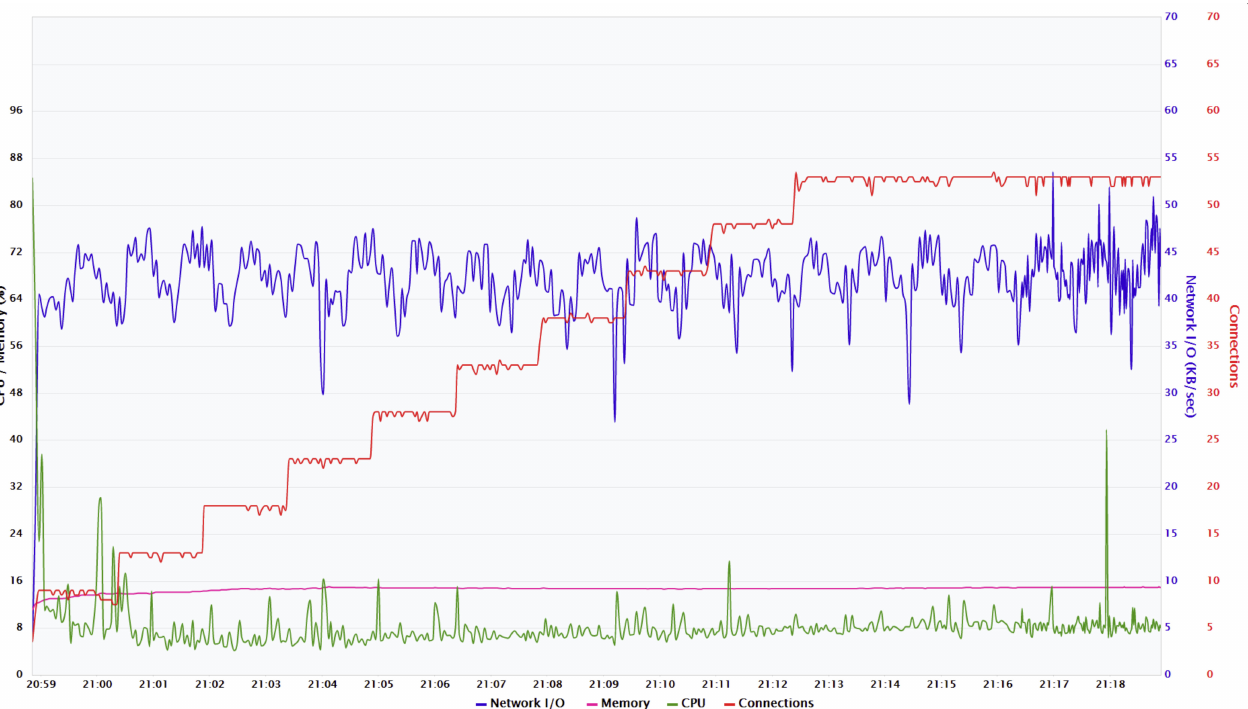
Figure 4. Engine Health Report SPIDEP-SOA-K8s-T1. The colored lines represent various parameters as follows: the blue line is the bandwidth traffic; the purple line is the memory load generated by the users; the green line is the CPU load generated by the users; and the red line is the active connections within the test.